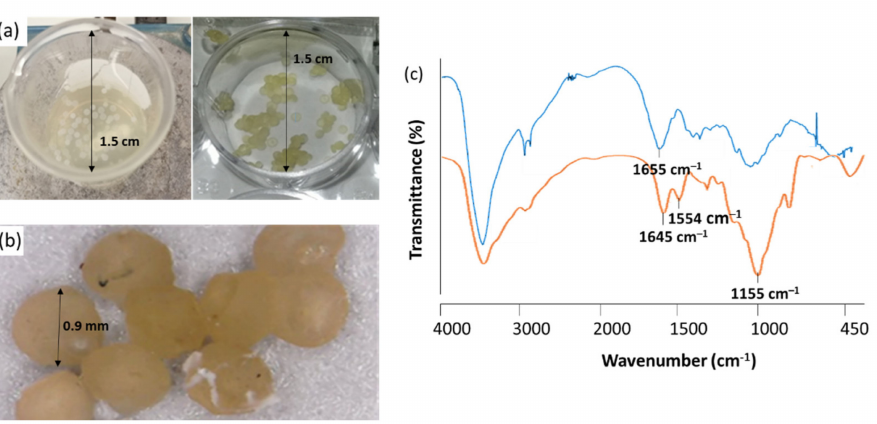
Figure 3. ( a ) Ch/TPP/Alg beads formation medium during Ch addition (left) and after precipita- tion (right); ( b ) microscopic view of microspheres sediment; ( c ) FTIR spectrum of Ch (blue) and Chitosan/TPP/Alg beads